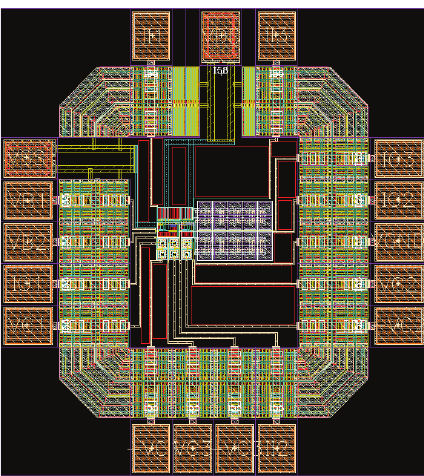
Figure 3: The chip layout of proposed current-mode universal biquadratic filter.